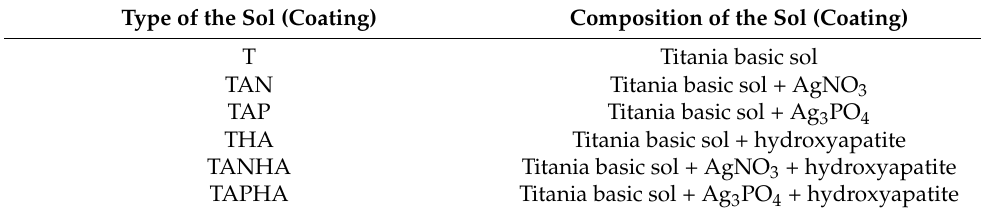
Table 1. Composition of the sols and coatings prepared from them. Type of the Sol